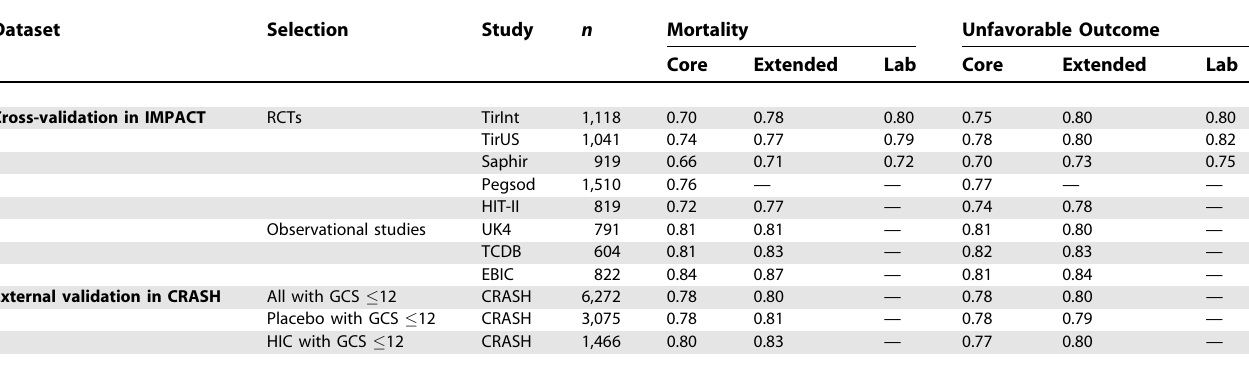
Table 3. Discriminative Ability of the Models at Cross-Validation in IMPACT Patients (Studies with n . 500), and External Validation in Patients from the CRASH Trial